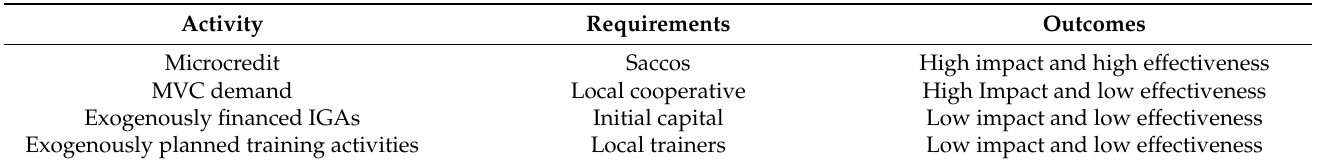
Table 5. Main outcomes from the quantitative analysis about complementary